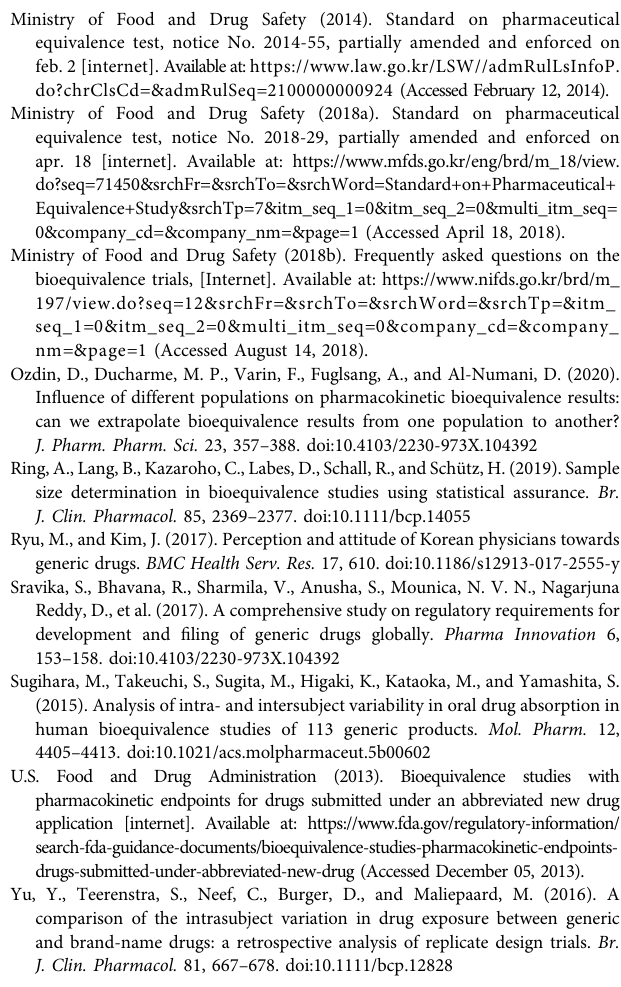
SUPPLEMENTARY FIGURE 1 | Interstudy variability of the number of subjects in2 × 2 × 4bioequivalence(BE)trials.Dotsrepresentthemediannumberofsubjects in each drug and horizontal lines represent minimum and maximum number of subjects.Differencebetweentheminimumandmaximumnumberofsubjects[the number of BE studies] are presented in the text. ATC classi fi cation for each drug was provided with colors. (Notes: Drugs with more than three BE studies were selected. Fixed-dose combination drugs were excluded from the